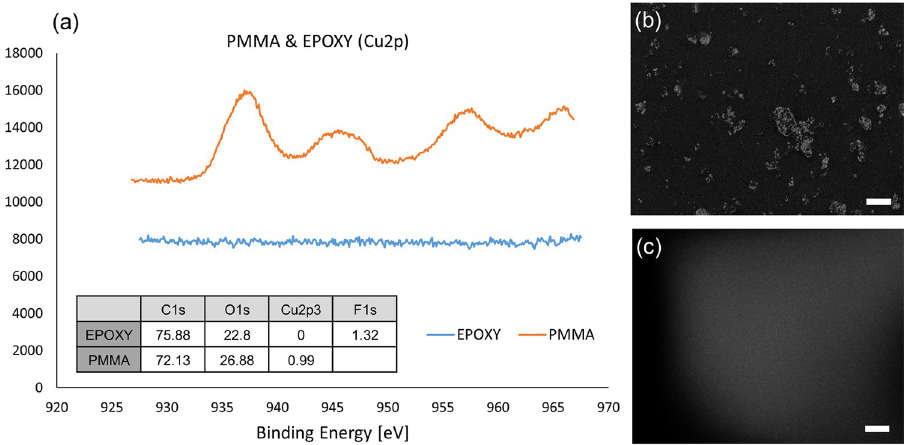
Fig 2. Characterization of samples. (a) XPS results of polymers. (b) SEM images of PMMA solution with 20% CuO NPs (c) SEM images of epoxy solution with 20% CuO NPs. Scale bar: 10 μ m.